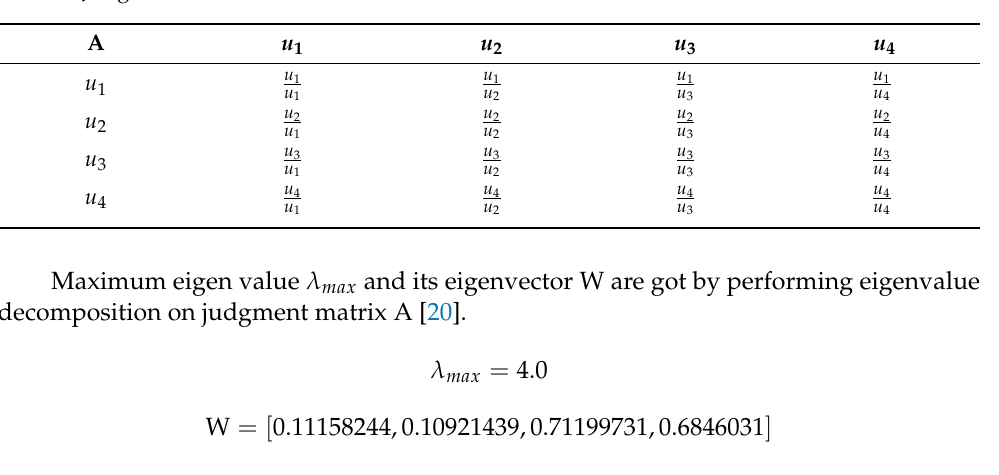
Figure 17. Visualization of simulated images. The four images of each models represent BMP2, BTR60, T72 and T62 respectively. ( a ) Simulated images generated by VAE. ( b ) Simulated images generated by DCGAN. ( c ) Simulated images generated by WGAN-GP. ( d ) Simulated images generated by NICE. Table 3. Judgment